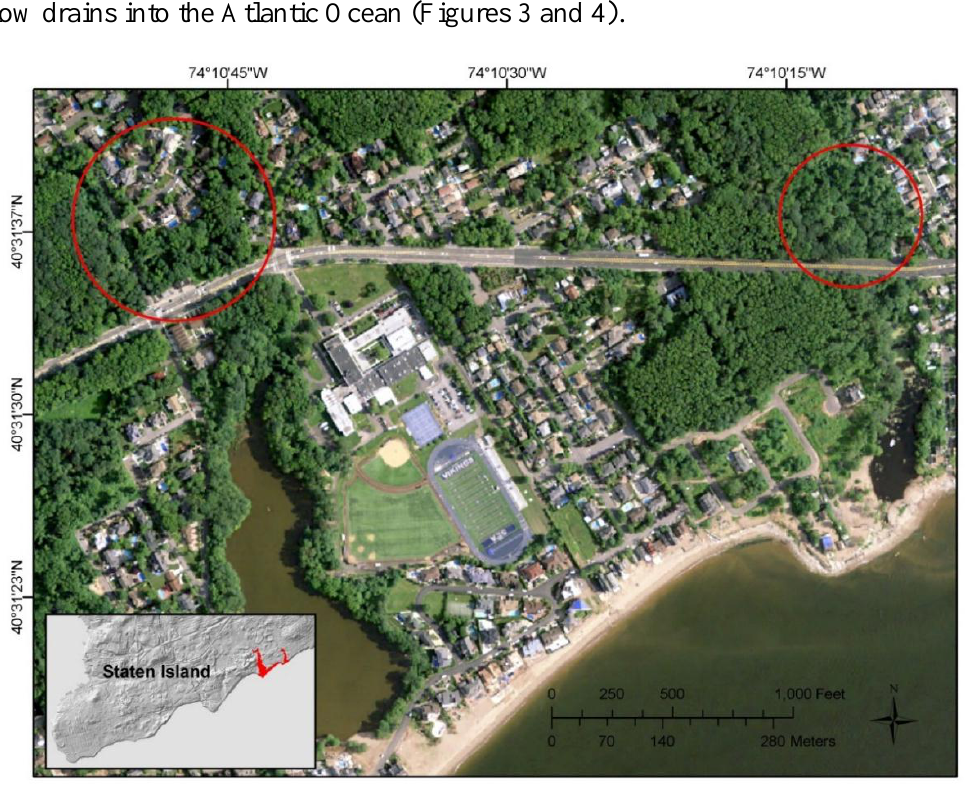
Figure 6. Aerial photograph of the same location shown in Figures 3 and 4. The inland areas in need of hydrologic connectivity (red circles) are located in a densely vegetated area. The 2013 imagery was obtained from the U.S. Department of Agriculture, National Agriculture Imagery